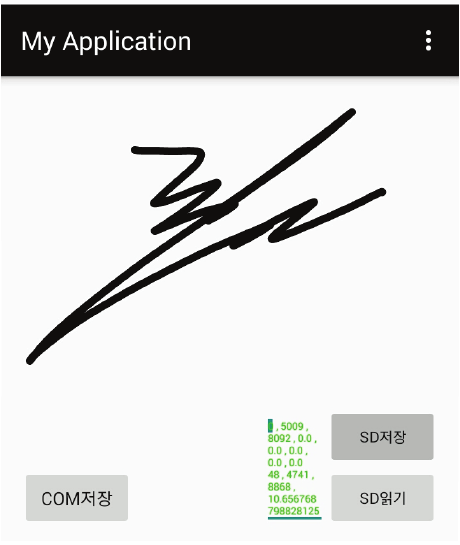
Figure 1. Original